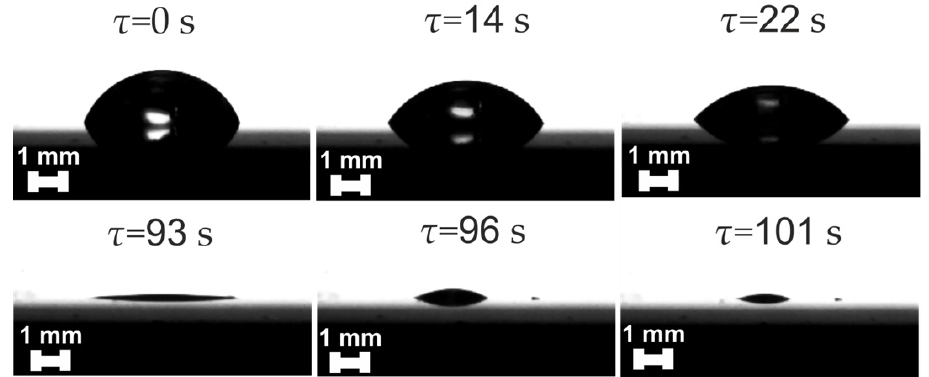
Figure 5. Photo images of water droplet evaporation when the three-phase contact line moves nonuniformly during the transition from the CCD to the mixed stage on St 46.3 surface.